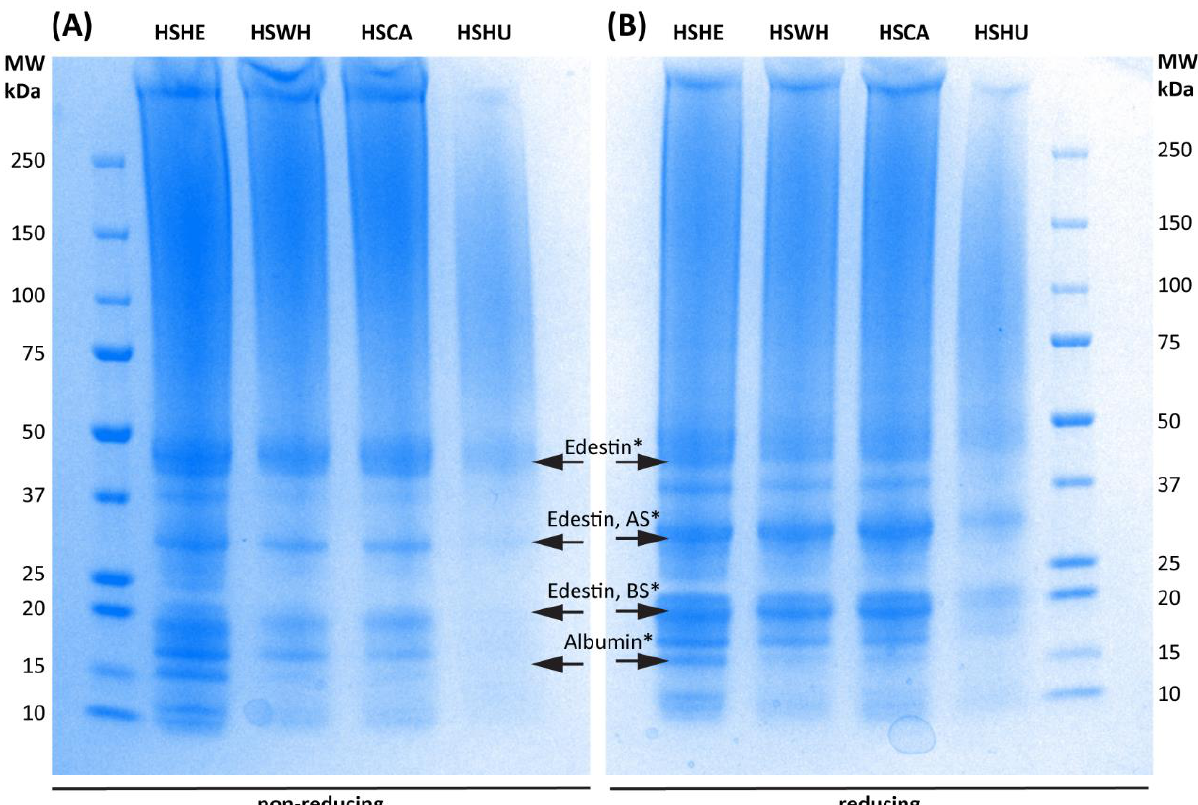
Figure 3. Non-reducing ( A ) and reducing ( B ) SDS-PAGE profiles for protein isolates extracted from hemp seeds and hemp by-products at 0.1 M NaOH. HSHE — hemp hearts; HSWH — hemp whole seed; HSCA — hemp cake; HSHU — hemp seed hulls. * Based on previously published data from Wang et al. (2019) [20] and Pavlovic et al. (2019) [21].